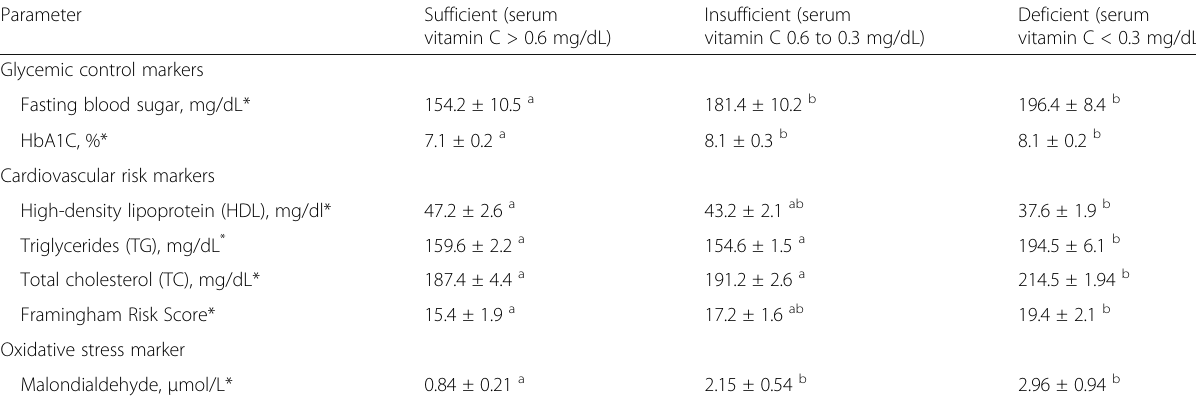
Table 2 Glycemic control, cardiovascular risk, and oxidative stress markers of selected participants ( n = 292) Parameter